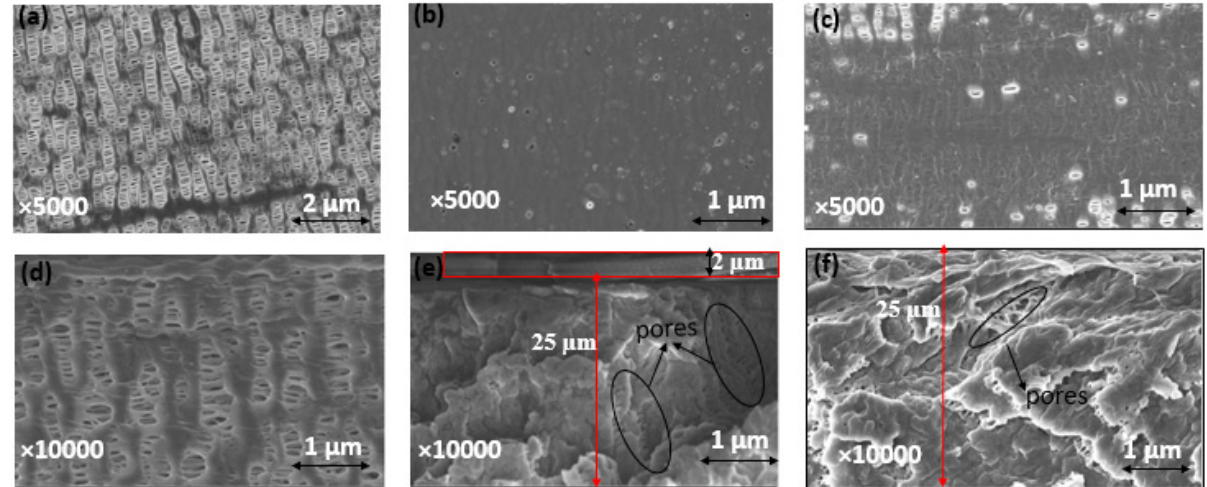
Figure 4. Surface SEM images of ( a ) Celgard ® 3501, ( b ) PPO-3.45 + 3501, ( c ) FAA + 3501 and SEM cross section view of ( d ) Celgard ® 3501, ( e ) PPO-3.45 + 3501, and ( f ) FAA + 3501 membranes. The densities of dense self-standing PPO-3.45 and FAA membranes were determined to be 1.17 and 1.14 g cm − 3 , respectively.